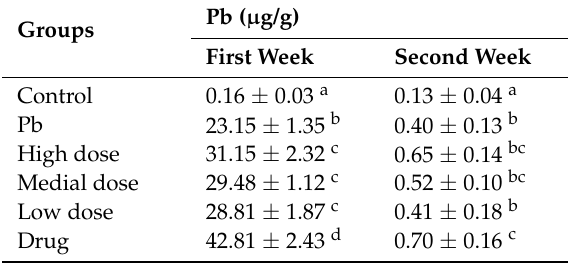
Table 4. Effects of L. bulgaricus KLDS1.0207 on Pb level in feces under different time.